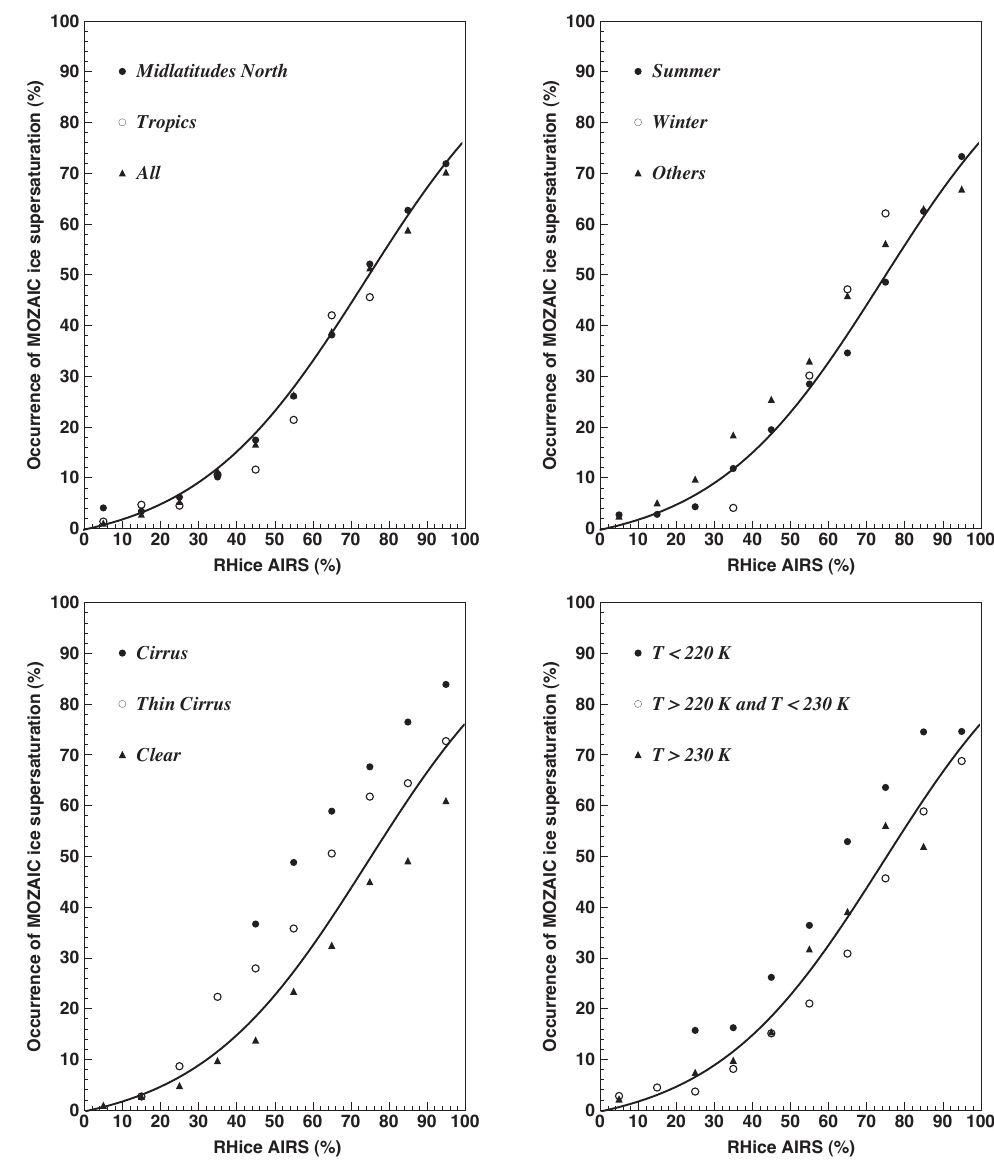
Fig. 7. Occurrence probability of ice supersaturation seen from MOZAIC as a function of AIRS relative humidity. MOZAIC supersaturation is declared when RHi M > 100%. Top left: sorted by regions, top right: sorted by seasons for the northern hermisphere midlatitudes. Bottom left: sorted by cloud types, bottom right: sorted by temperature. In all figures the baseline S-function (RHi M > 100%) from Fig. 6 is reproduced in plain